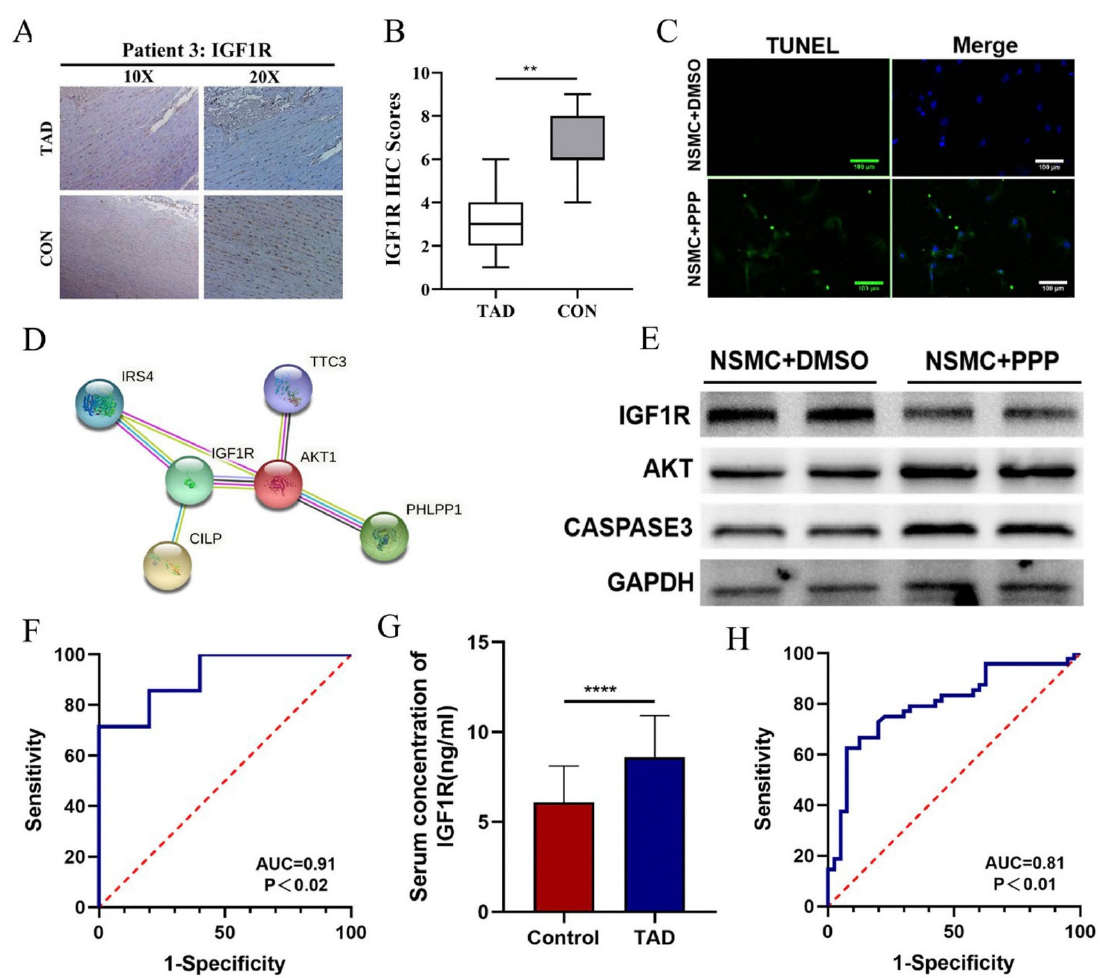
Figure 7. IGF1R downregulation mediates VSMC apoptosis by promoting AKT expression. ( A ) The expression of IGF1R protein in TAD aortic wall tissue and respective adjacent CON tissues were analyzed using IHC. ( B ) IGF1R expression scores are shown as box plots. (**, p < 0.001). ( C ) Tunel stain showed PPP-induced apoptosis of NSMC. ( D ) STRING database shows IGF1R interaction with AKT. ( E ) Western blot showed that PPP-induced downregulation of IGF1R expression in NSMC further leads to the increased expression of AKT and Caspase3. ( F ) Receiver operating characteristic analysis of the sensitivity and specificity of the predictive value of the IGF1R in GSE52093. ( G ) The serum concentration of IGF1R levels between the TAD and normal patients in our data (****, p = 0.000). ( H ) Receiver operating characteristic analysis of the sensitivity and specificity of the predic- tive value of the serum concentration of IGF1R levels in our data. 3.5. IGF1R Can Be Considered as a Diagnostic Marker for TAD The area under the ROC curve ( p < 0.02, AUC = 0.91) indicates that the IGF1R have potential diagnostic value and might serve as biomarkers of TAD in GSE52093 (Figure 7F). To further verify the diagnostic efficacy of IGF1R, the IGF1R levels in plasma from 48 TADs and 40 healthy controls were measured by ELISA (Figure 7G and Supplementary Figure S3). Our results show that the IGF1R levels in plasma were significantly increased